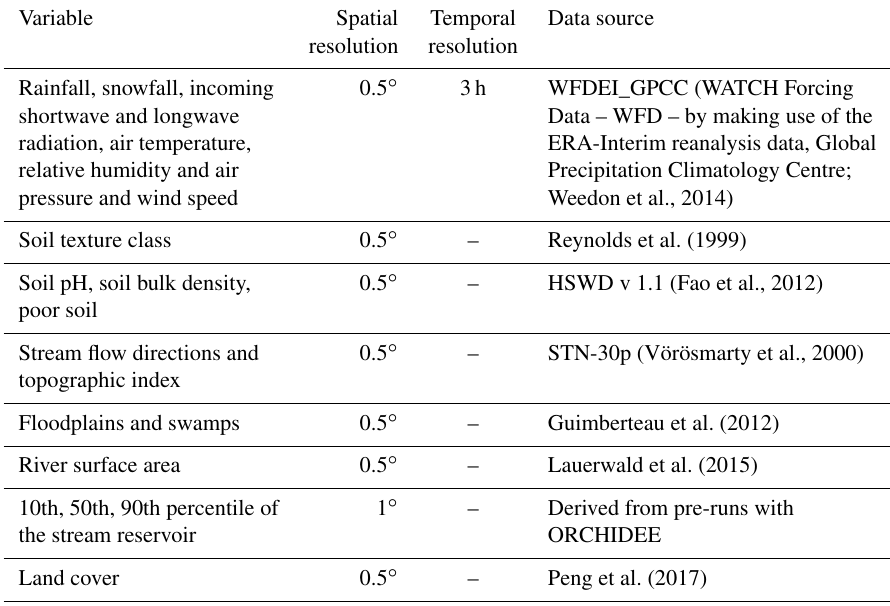
Table 1. List of the forcing files used for our simulations, along with their spatiotemporal